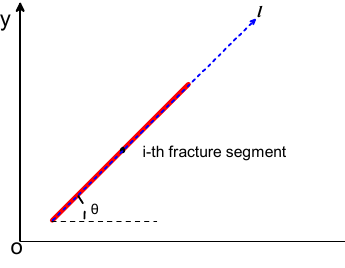
Figure 2. Fracture segment with an azimuth angle of θ .